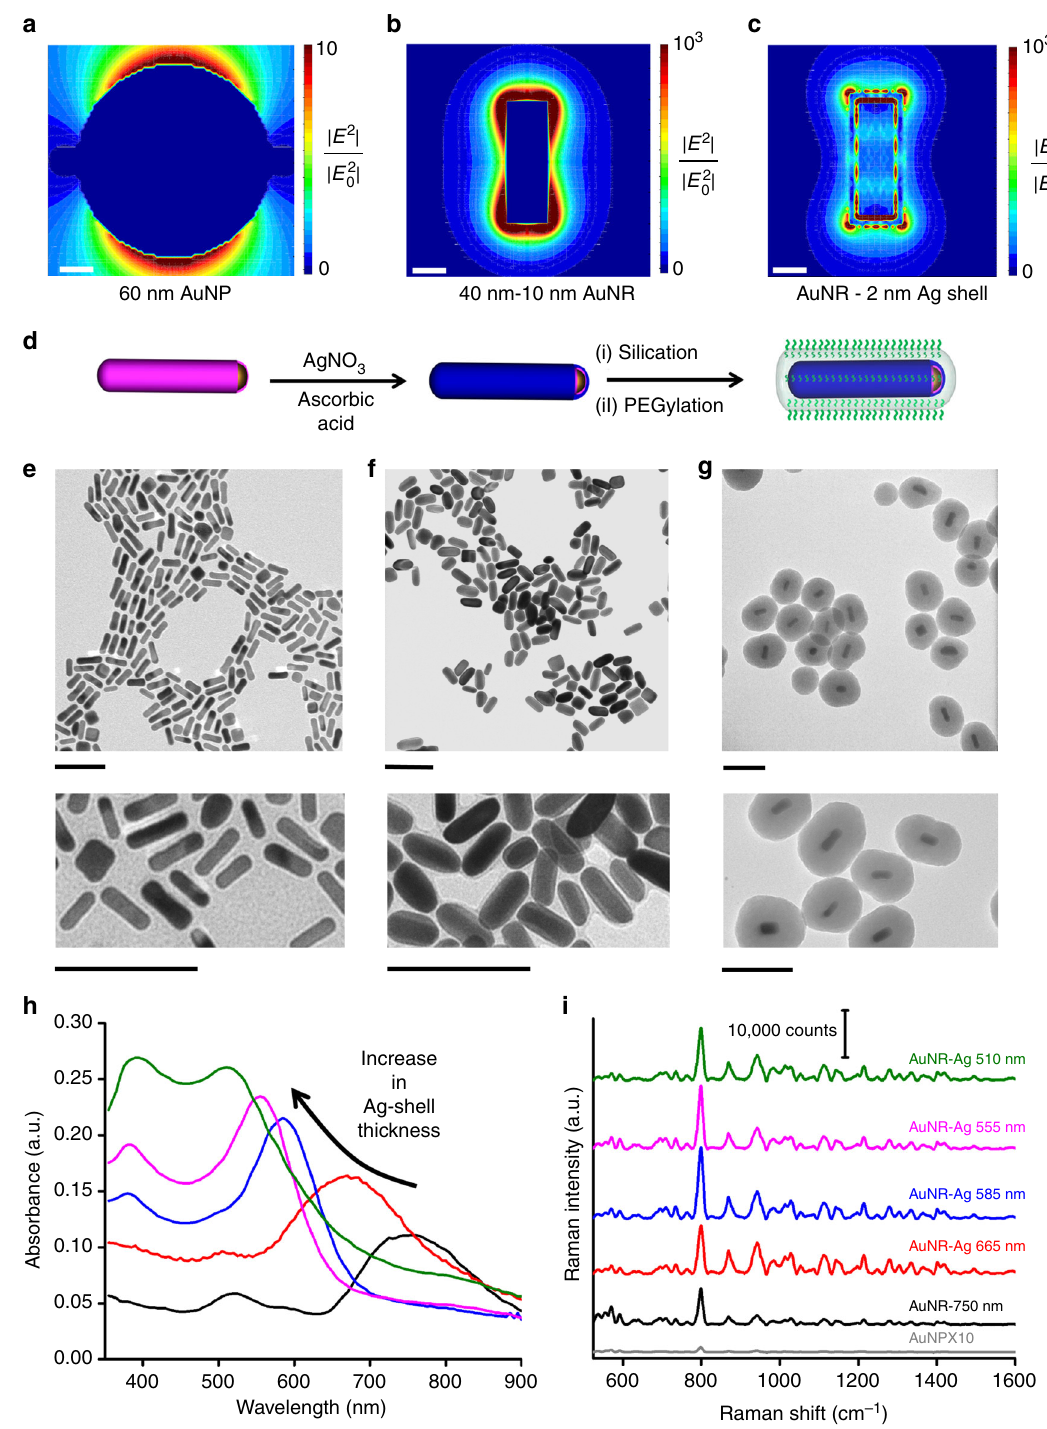
Fig. 4 Plasmonic core and shell selection. Electric fi eld enhancement maps of different plasmonic cores: a 60-nm AuNP, b 40-nm length – 10-nm diameter AuNR, and c AuNR with 2 nm gap and 2 nm Ag shell. The average electric fi eld enhancement factor is increased by 2 orders of magnitude predicting a higher SERS enhancement with a AuNR core and a Ag shell. Scale bars are 10 nm. d Synthesis of the optimized FRNPs. Different thicknesses of Ag shell are formed by reducing different concentrations of AgNO 3 with ascorbic acid in the presence of DNA cloaked AuNR cores. e – g TEM images (lower panels are magni fi ed views) of fl uorophore cloaked AuNR cores, AuNR core with a 2 nm Ag shell and fully optimized FRNPs with PEG-2000 coated silica shell. All the scale bars are 100 nm. h UV – vis spectra of the AuNRs with increasing thickness of silver shell showing a hypsochromic shift of localized surface plasmon resonance (LSPR) peaks. i Fluorescence background subtracted Raman spectra of 10 fM of the spherical AuNP-based FRNPs and 1 fM of AuNR-based FRNPs with increasing thickness of Ag. The FRNP with longitudinal LSPR maximum of 585 nm exhibits the maximum Raman